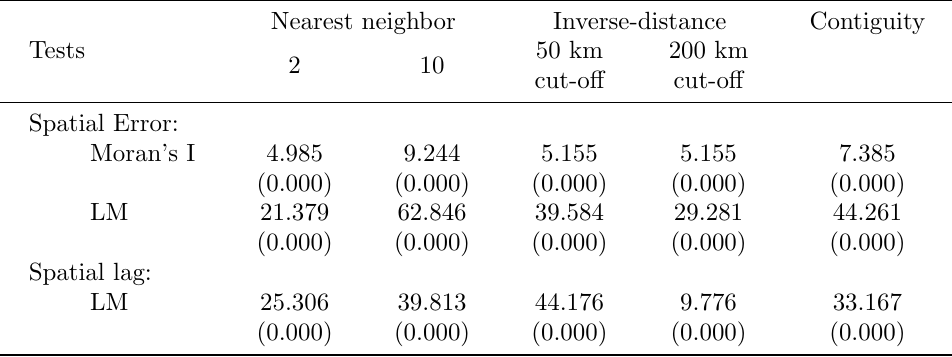
Table 4: Diagnostic tests (statistics and